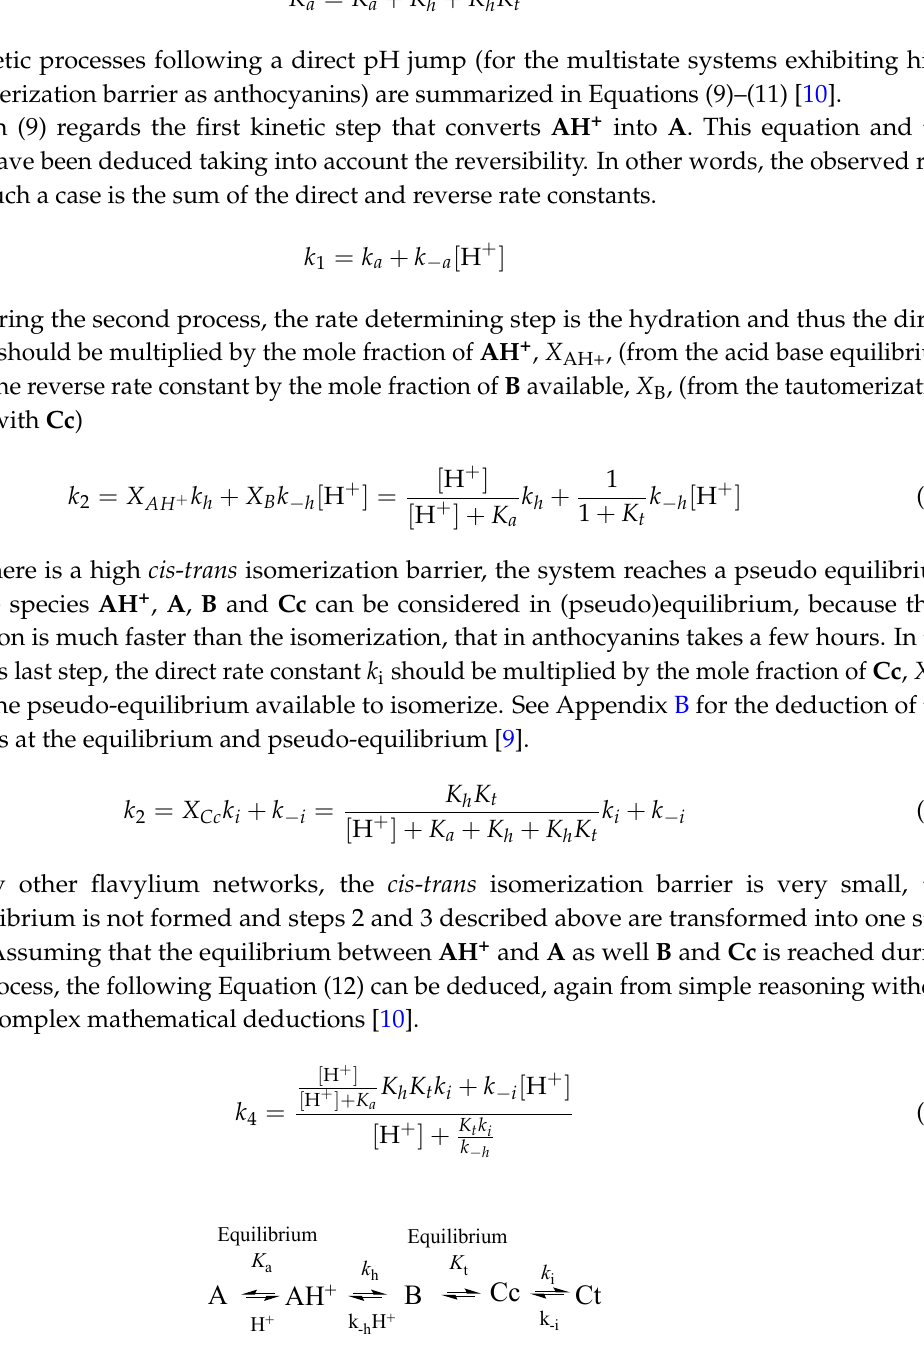
Scheme 3. Flavylium network for compounds with small isomerization barrier: A / AH + and B / Cc are in fast equilibrium.